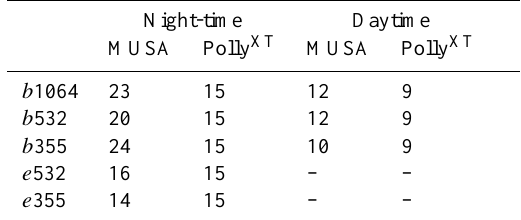
Table 2. Number of MUSA (Potenza) and Polly XT (Leipzig) mea- surement cases included in the calculation of the mean profiles shown in Figs. 9–13. The quantity b 1064 indicates the backscat- ter coefficient profile derived with the iterative method at 1064nm while b 532 ( b 355) and e 532 ( e 355) represent backscatter and ex- tinction coefficient profiles at 532nm (355nm), respectively.